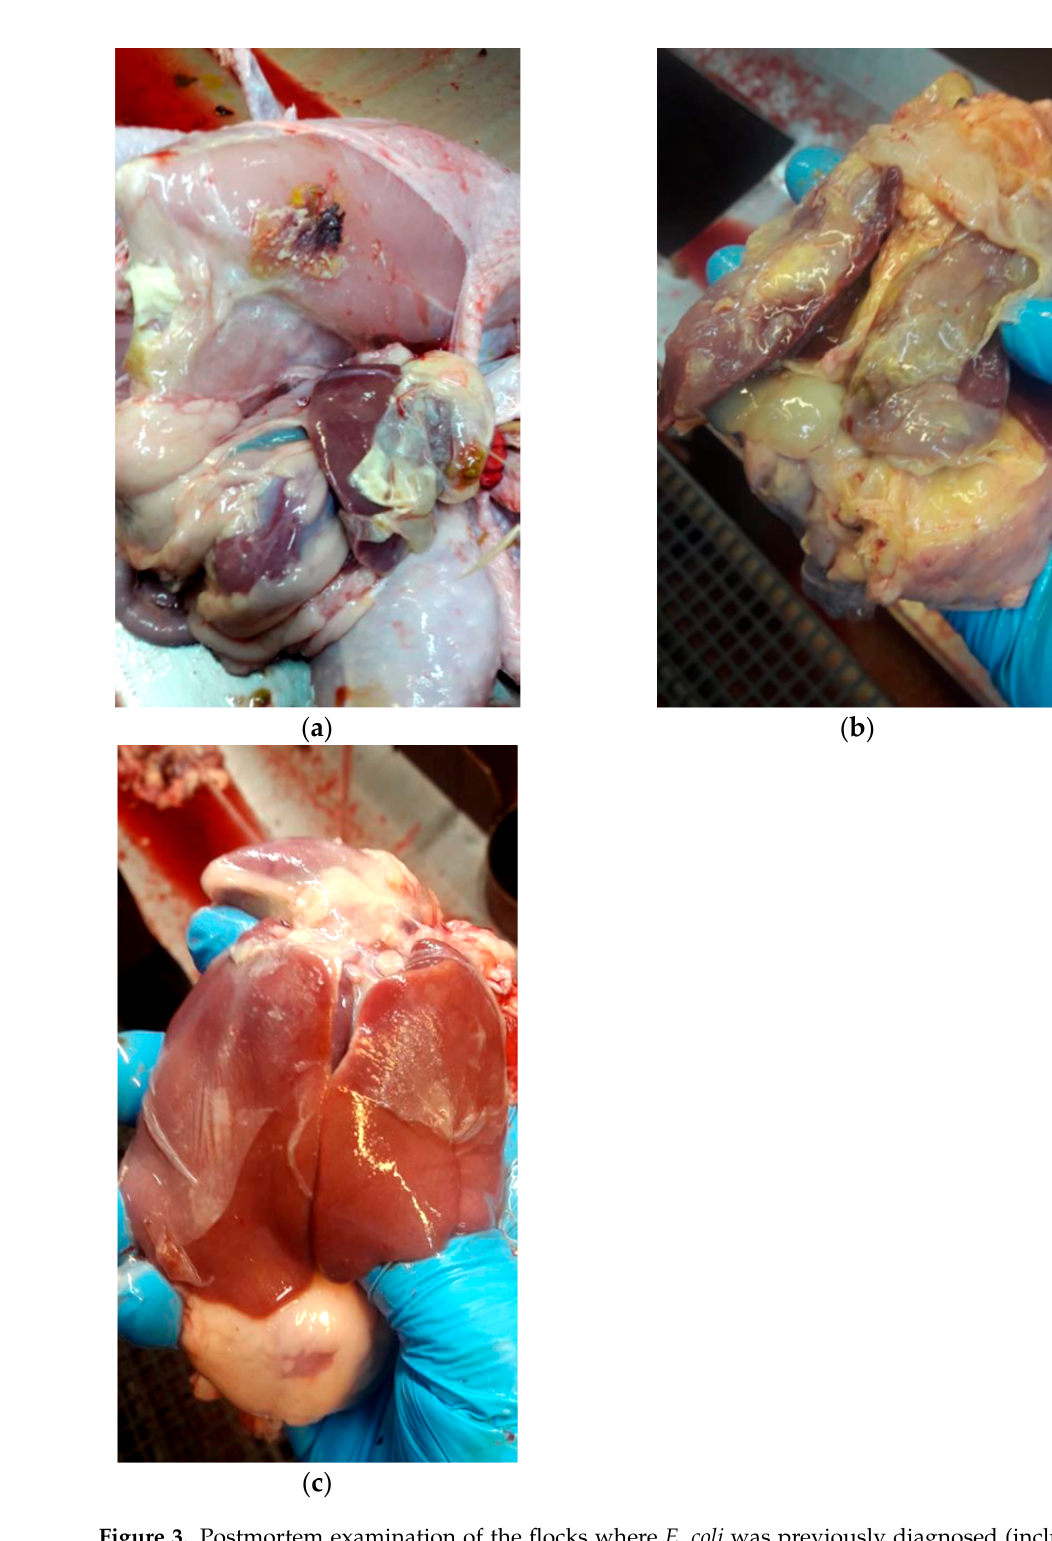
Figure 3. Postmortem examination of the flocks where E. coli was previously diagnosed (including APEC). Changes were present on both; inside the carcass and organs; fibrinous peritonitis, pericarditis and thin layer of fibrous exudate located on liver ( a – c ). In addition to the changes described above, there was a visible flock uniformity in terms of weight and size of birds delivered to the slaughterhouse.